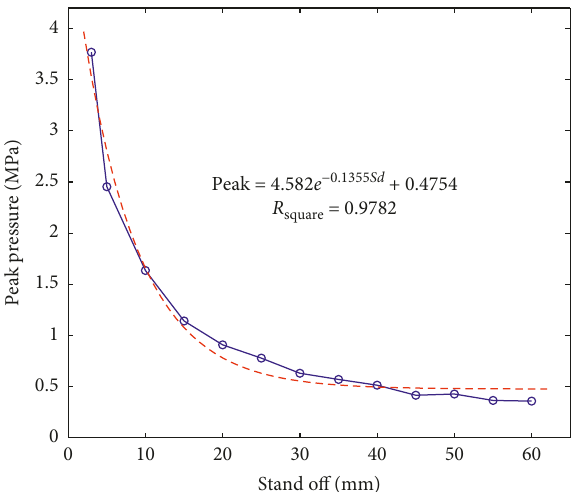
Figure 16: Shock wave pressure loading’s peak versus